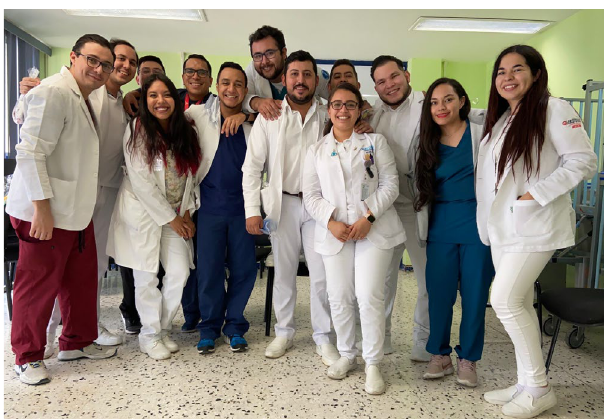
Figure 1. Medical Interns and Resident Physicians of the General Hospital of Pabellón de